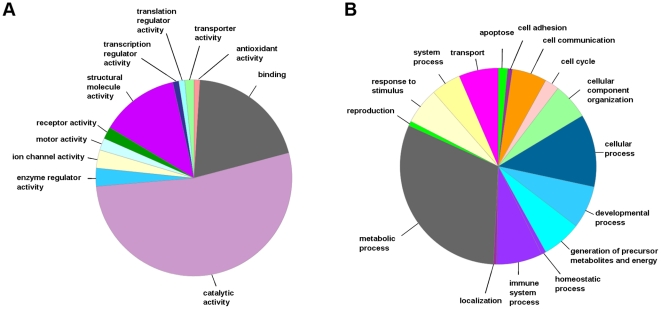
Classification of differentially expressed proteins according to their cellular function.The pie charts display the classification of the subset of differentially expressed proteins listed in Table S1 divided into 11 molecular functional categories (A) and into 16 biological processes (B). Molecular functions regulated by the differentially expressed proteins classified by Gene Ontology.